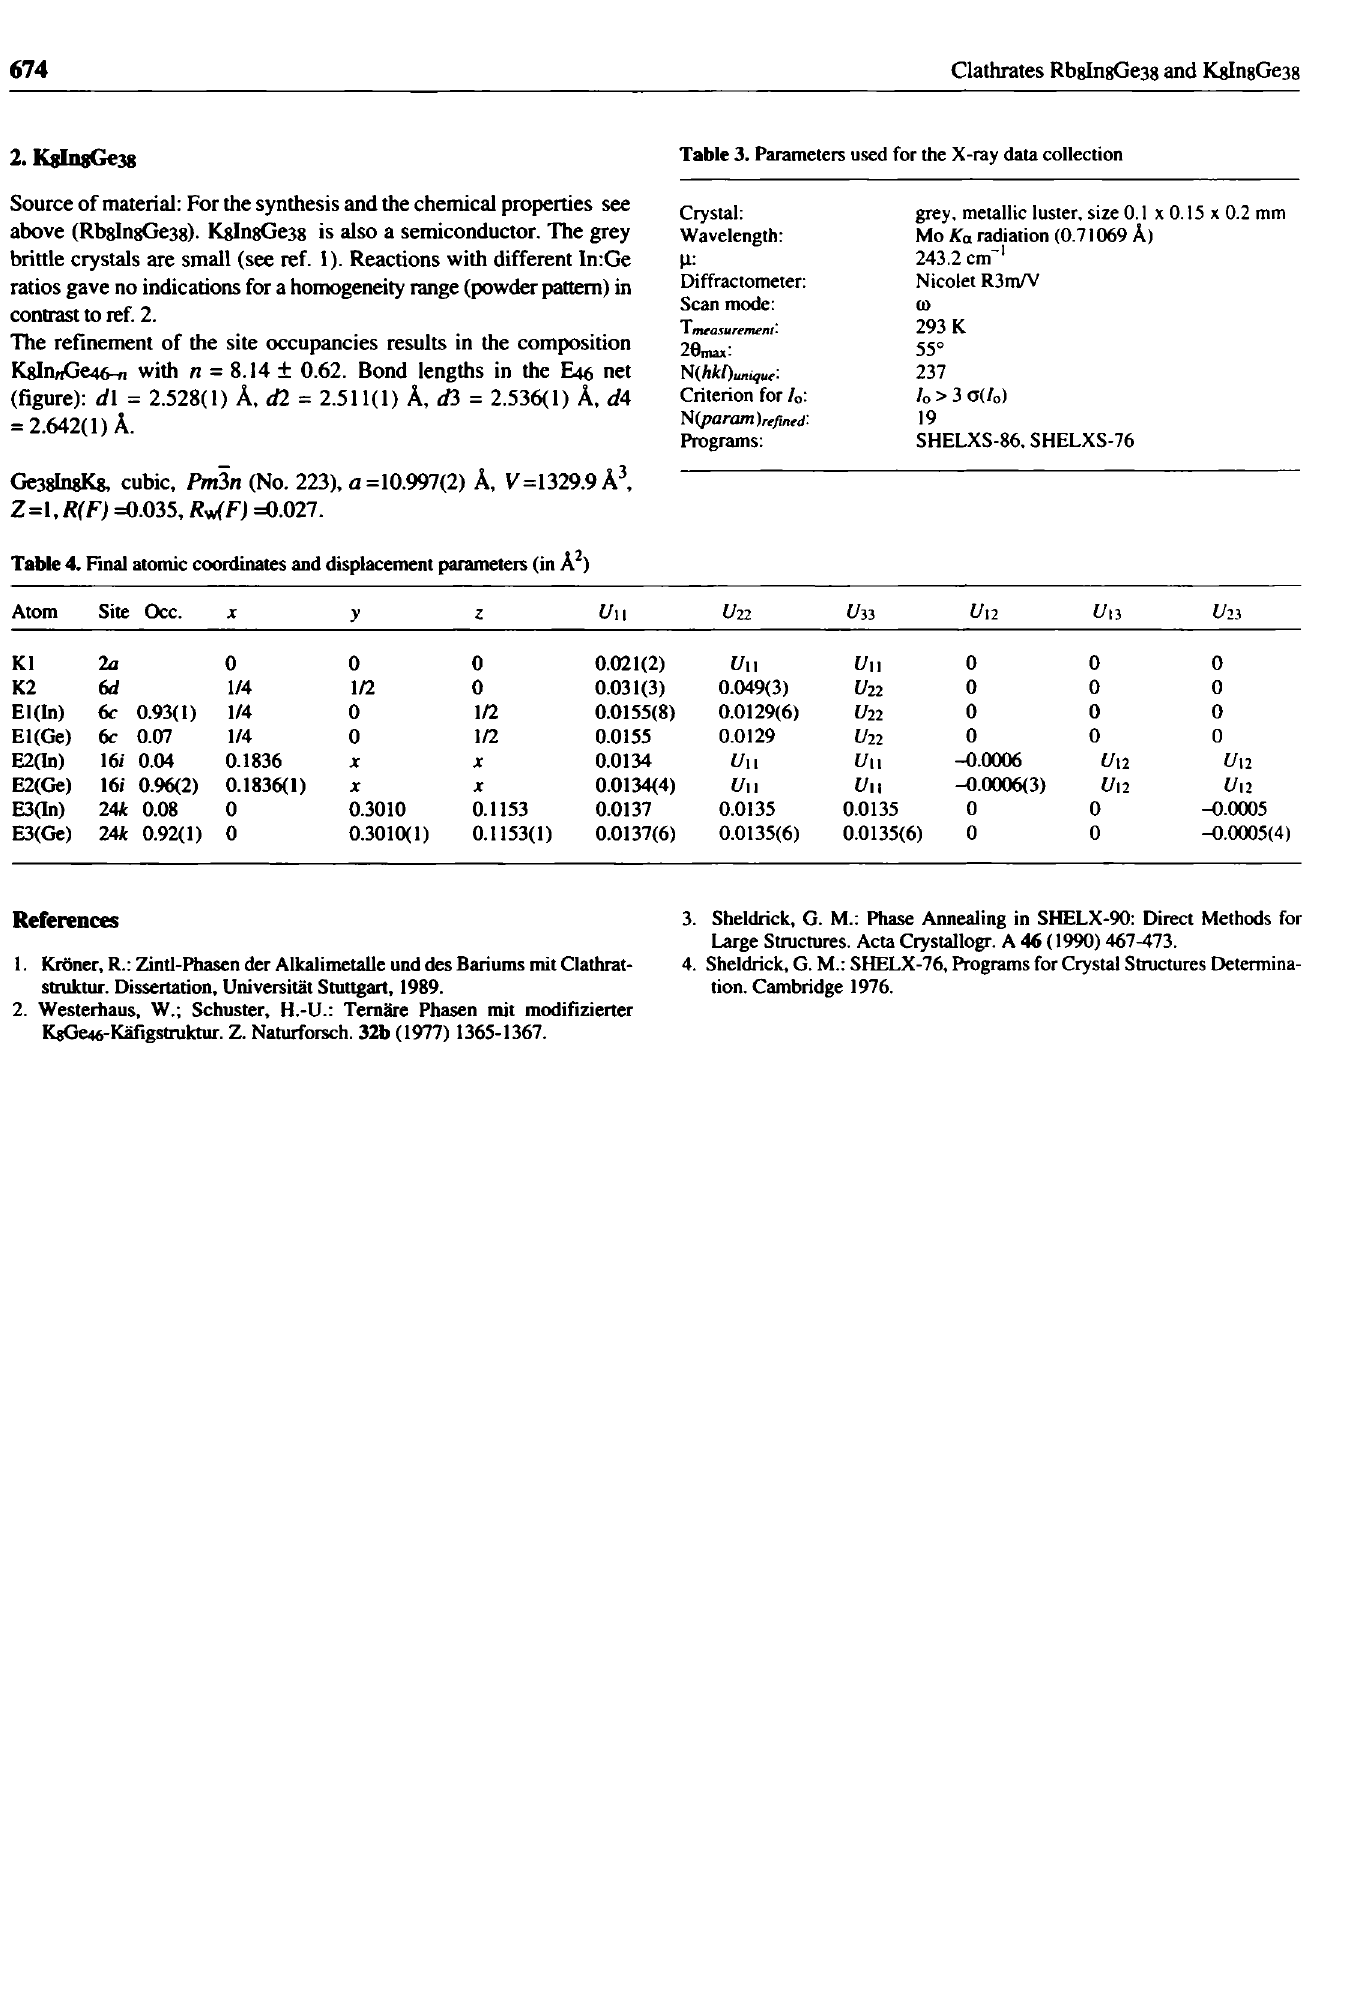
Table 3. Parameters used for the X-ray data collection